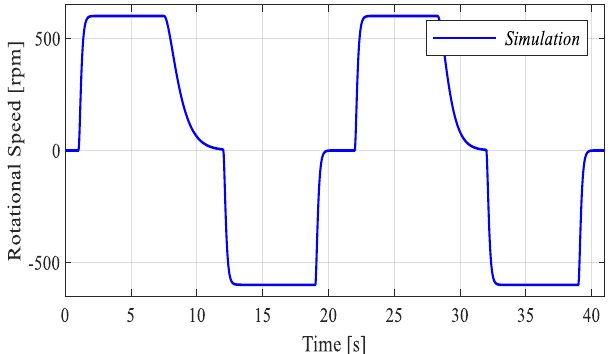
Figure 11. Pump / motor rotational Figure 11. Pump/motor rotational speed.